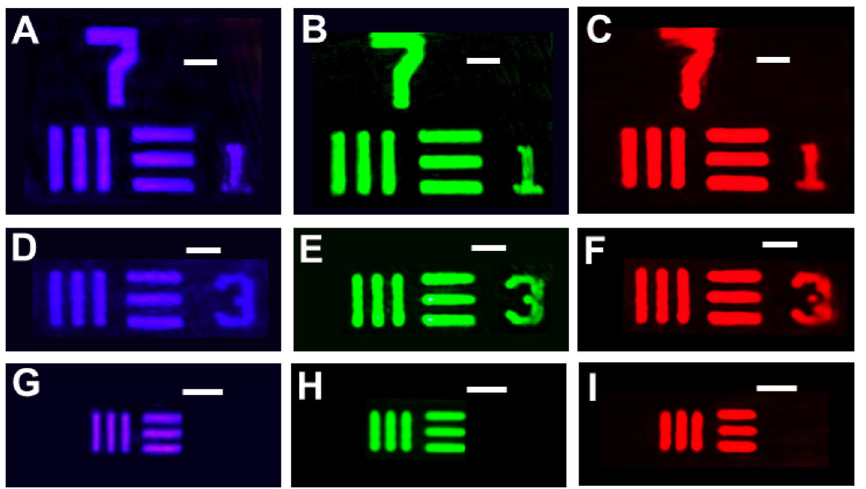
Figure 4. Imaging with the metalenses. ( A – I ) Images of the 1951 USAF resolution test chart formed by the metalenses at laser wavelengths of ( A , D , G ) 405, ( B , E , H ) 532, and ( C , F , I ) 633 nm. ( A – C ) The smallest features are lines with widths of 3.9 µm and center-to-center distances of 7.8 µm. ( D – F ) The smallest features are lines with widths of 3.1 µm and center-to-center distances of 6.2 µm. ( G – I ) The smallest features are lines with widths of 2.2 µm and center-to-center distances of 4.4 µm. Scale bar, 10 μm in ( A – I